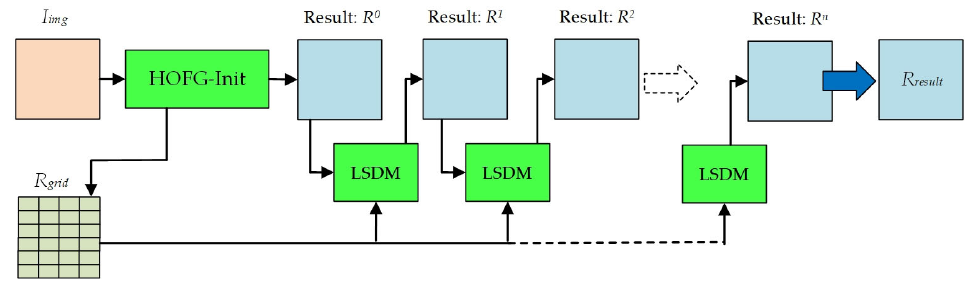
Figure 5. Hierarchical object-focused segmentation process.